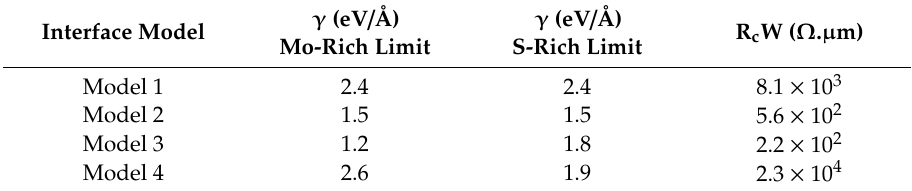
Table 1. Computed interface formation energies γ of the different graphene/MoS 2 interface models shown in Figure 5, in the Mo-rich and S-rich limit, respectively. The value of the computed contact resistance R c W of each interface model is also given.